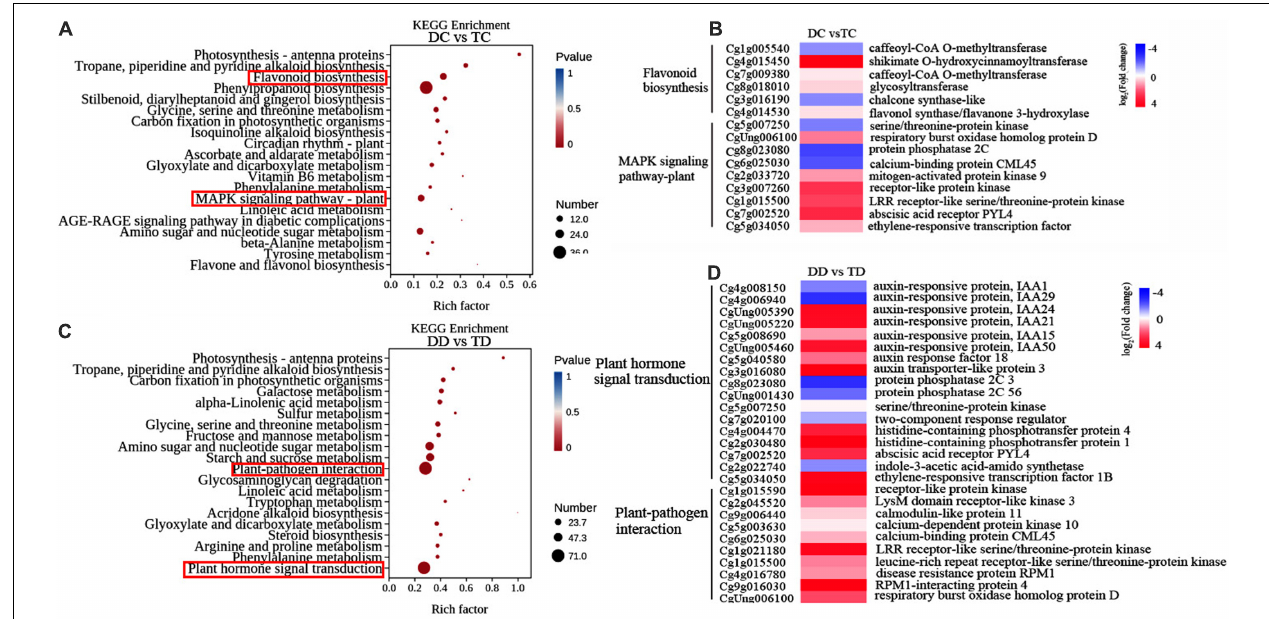
FIGURE 8 | Kyoto Encyclopedia of Genes and Genomes enrichment and hierarchical clustering analysis of the DEGs. The top 20 pathways with the highest enrichment level were exhibited according to the amount and enrichment level of DEGs annotated in DC vs TC (A) and DD vs TD (C) , respectively; Hierarchical clustering analysis of the DEGs in DC vs TC (B) and DD vs TD (D) ,